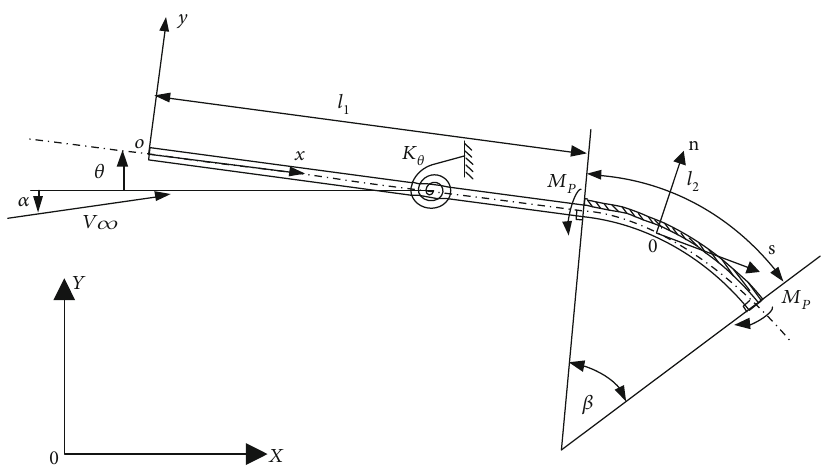
Figure 1: The morphing piezoelectric wing